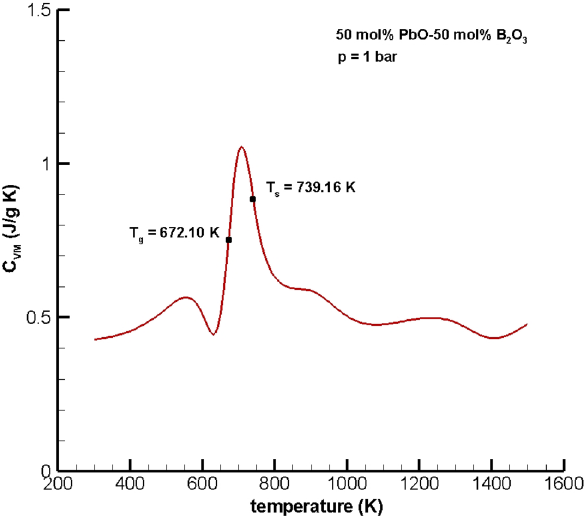
Figure 5. Heat capacity, C V , vs. temperature for 50 mol% lead monoxide-50 mol% boron trioxide glass at 1 bar predicted by Monte Carlo Simulation using the linear mixing rule for U